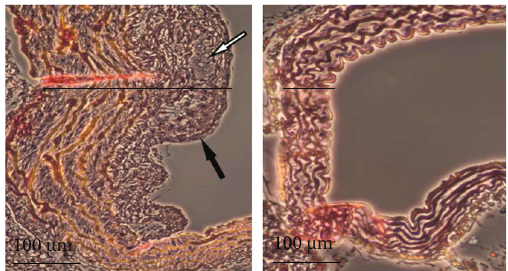
Figure 2: Atherosclerotic vs. normal aortic root. Cross-section and HE staining of mouse aortic root (40-fold magni fi cation). (a) Aortic root of a C57/BL 6 LDLR-/- mouse after 14 weeks of high- fat/atherogenic diet. (b) Aortic root of a C57/BL 6 WT mouse without a high-fat diet. (a) Typical criteria for severe arteriosclerosis can be seen. Signi fi cant increase of the aortic wall thickness (black line) compared to the WT aorta in (b). Also further typical atherosclerotic morphological changes can be identi fi ed: plaque cap (black arrow), foam cells, and cholesterol crystals (white